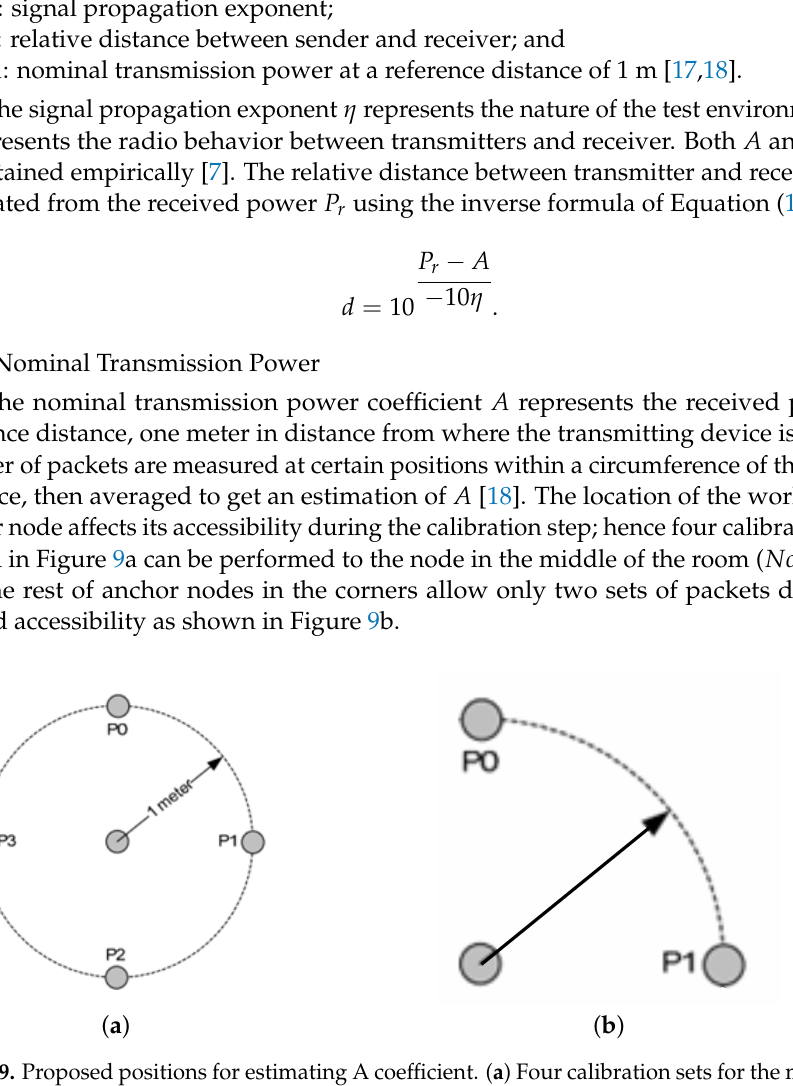
Figure 9. Proposed positions for estimating A coefficient. ( a ) Four calibration sets for the middle node; ( b ) Two calibration sets for corner